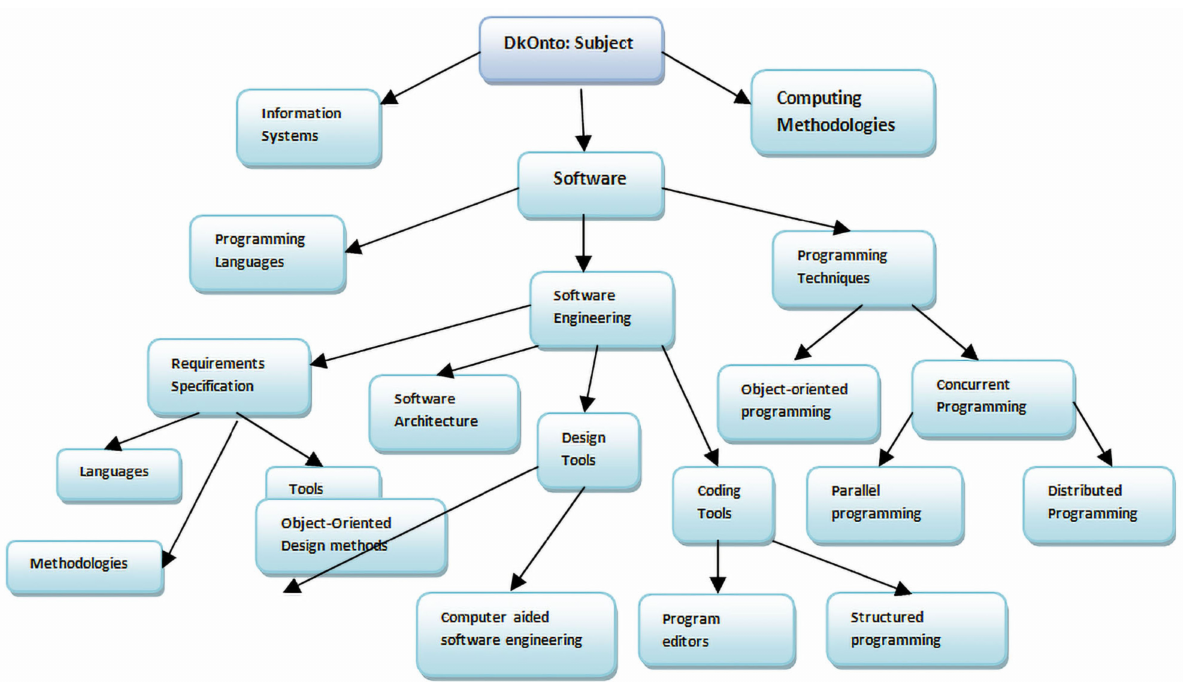
Figure 5. A portion of computer-science domain